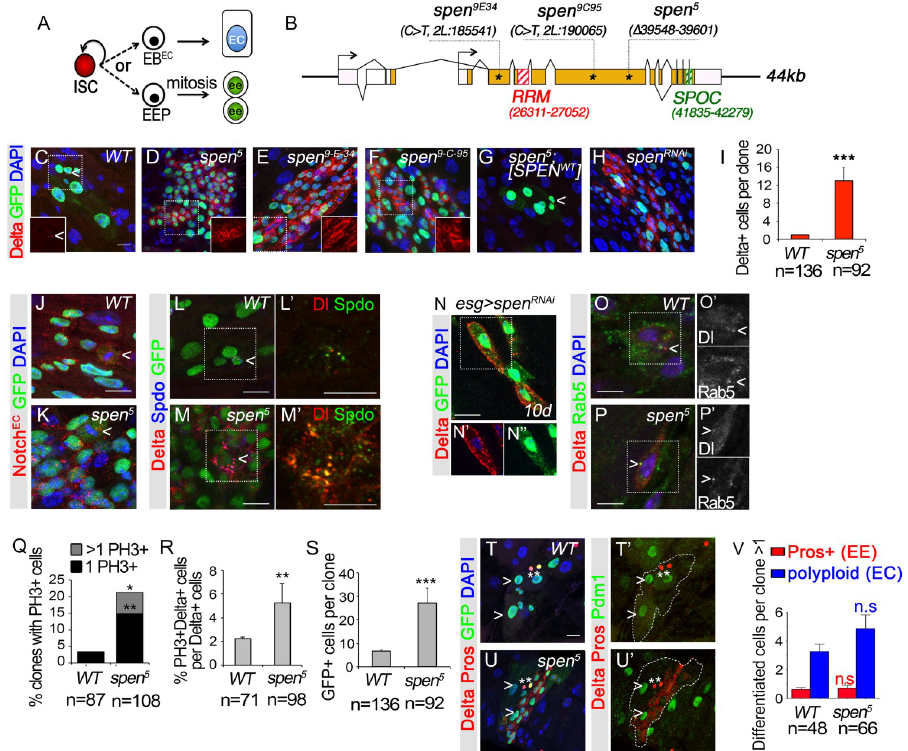
Fig 1. spen inactivation leads to an accumulation of intestinal stem cell-like cells in the adult midgut. (A) Intestinal stem cells (ISCs) produce post-mitotic progenitor cells, called enteroblasts (EBs) that directly terminally differentiate. Notch activated EBs (EB EC ) produce enterocytes (ECs) whereas enteroendocrine cells (EEs) are derived from ISCs in a Notch-independent manner via an EE progenitor (EEP) intermediate, which is thought to divide once. (B) spen gene encodes a protein characterized by 3 RNA recognition motifs (RRM) in the N-terminus (RED), and a SPOC (Spen Paralog Ortholog C-terminus) domain in the C-terminus (GREEN), both included in the different spen isoforms. The three mutant alleles spen 9E34 , spen 9C95 and spen 5 have premature stop codons, which are frequently targeted by nonsense-mediated decay. The spen 9E34 allele has a C > T substitution (2L:185541). The spen 9C95 allele has a C > T substitution (2L:190065). The spen 5 allele has nucleotide deletion (2L:192716–192769). (C) wild-type ( WT ), (D) spen 5 , (E) spen 9E34 and (F) spen 9C95 mutant clones 5d AHS marked by GFP (GREEN), Dl, (ISCs, RED), DAPI (BLUE). Insets show RED channel only. (G) A transgenic BAC construct containing the spen wild-type genomic region suppressed spen 5 phenotypes in 5 days MARCM clones. (H) spen RNAi (VDRC#KK-108828) in MARCM clones (GFP, GREEN; DAPI, BLUE), 5 days. (I) Quantification of Dl+ cells per clone, 5 days AHS. (J) wild-type and (K) spen 5 mutant clones had ISCs (mitotic cells, arrow heads) expressing the Notch receptor (RED in J, K). (L, L’) wild-type clones or (M, M’) spen 5 mutant clones contained ISCs co-labeling with Dl (RED) and Sanpodo (Spdo, GREEN, L’, M’). A single focal plane is shown. An additional 2X zoom is shown in L’, M’. ( N-N” ) spen 7RNAi expression in esg + cells. A single focal plane is shown. (Delta, RED; cytoplasmic GFP, GREEN; DAPI, BLUE), 10 days. (O, O’) wild-type clones or (P, P’) spen 5 mutant clones contained ISCs co-labeling with Dl (RED) and Rab5::YFP. (GREEN, I’, J’ ) . A single focal plane is shown. (Q) Quantification of the % of wild-type and spen 5 mutant clones with mitotic cells (PH3), 5 days AHS. Fisher’s test. (R) Quantification of the number of PH3+ Dl+ cells per Dl+ cells. (S) Quantification of clone size in wild- type and spen 5 mutant clones. (T, T’) Enterocyte (EC) and enteroendocrine (EE, Pros, nuclear RED) cells were produced in wild-type and (U, U’) spen 5 mutant clones, clones marked by GFP (GREEN); EE (Pros, nuclear red); ISC (Delta, membrane RED); DAPI (BLUE). (V) Quantifications of EE and ECs per clone. When not specified, a non- parametric Mann-Whitney test was performed. Error bars represent the Standard Error of the Mean (sem). p < 0.05, � . p < 0.01, �� . p < 0.001, ��� . p < 0.0001, ���� . Scale bar:10 μ m.